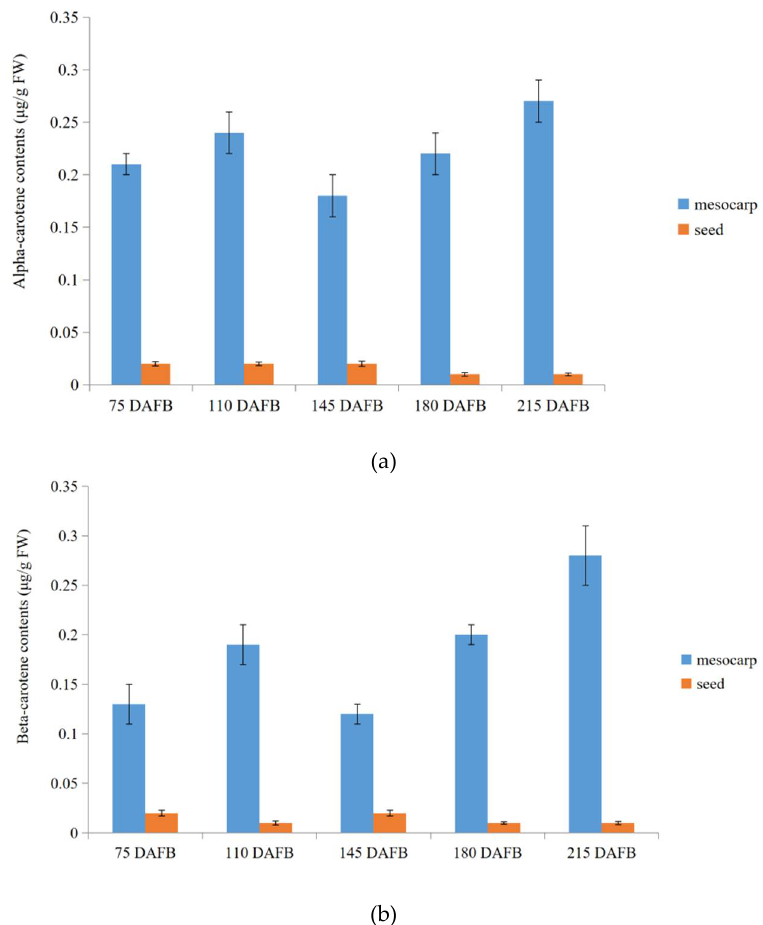
Figure 7. Alpha-carotene and beta-carotene contents during five avocado mesocarp ( a ) and seed ( b ) developmental stages.